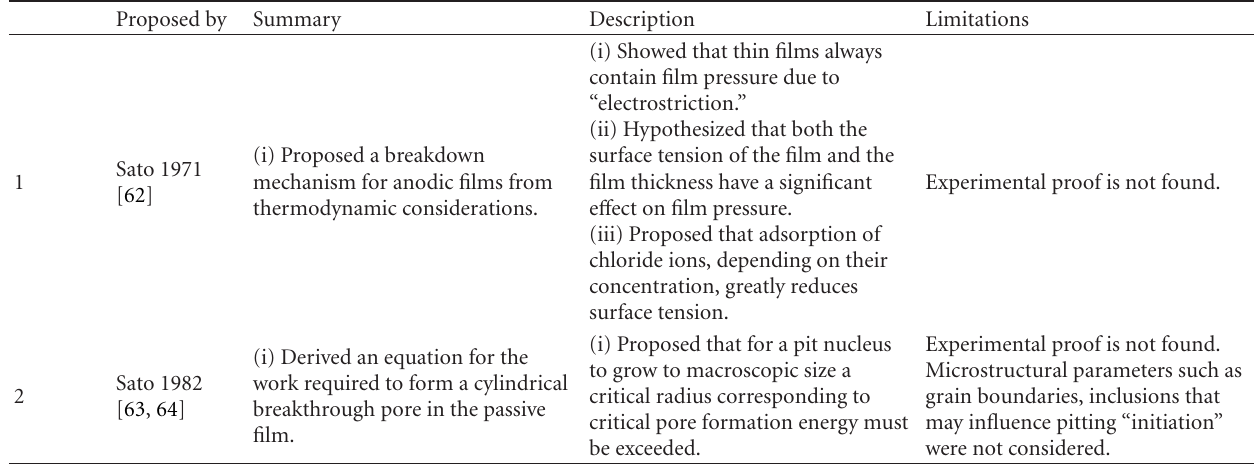
Table 7: Chemicomechanical breakdown